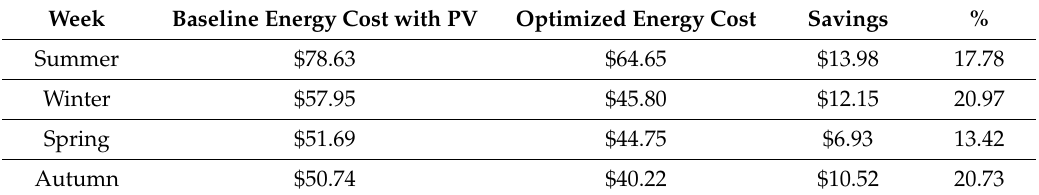
Table 4. Scenario 2 weekly